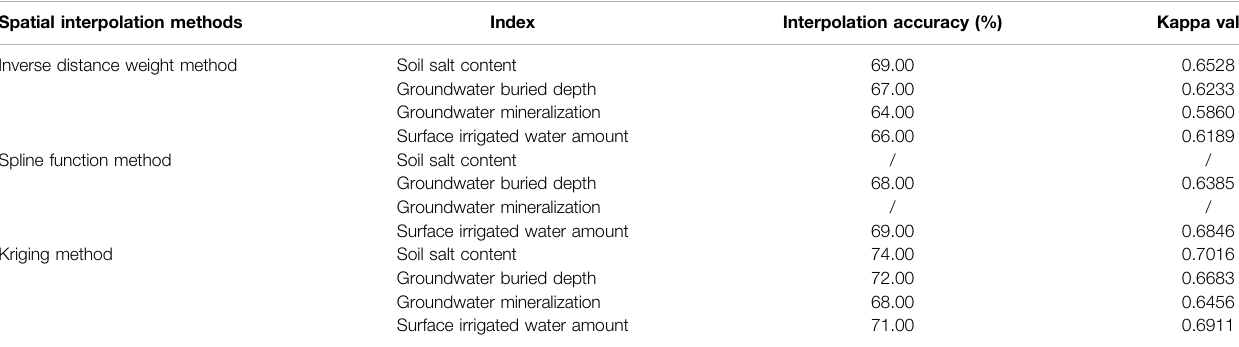
TABLE 2 | Evaluation table of interpolation accuracy for different spatial interpolation